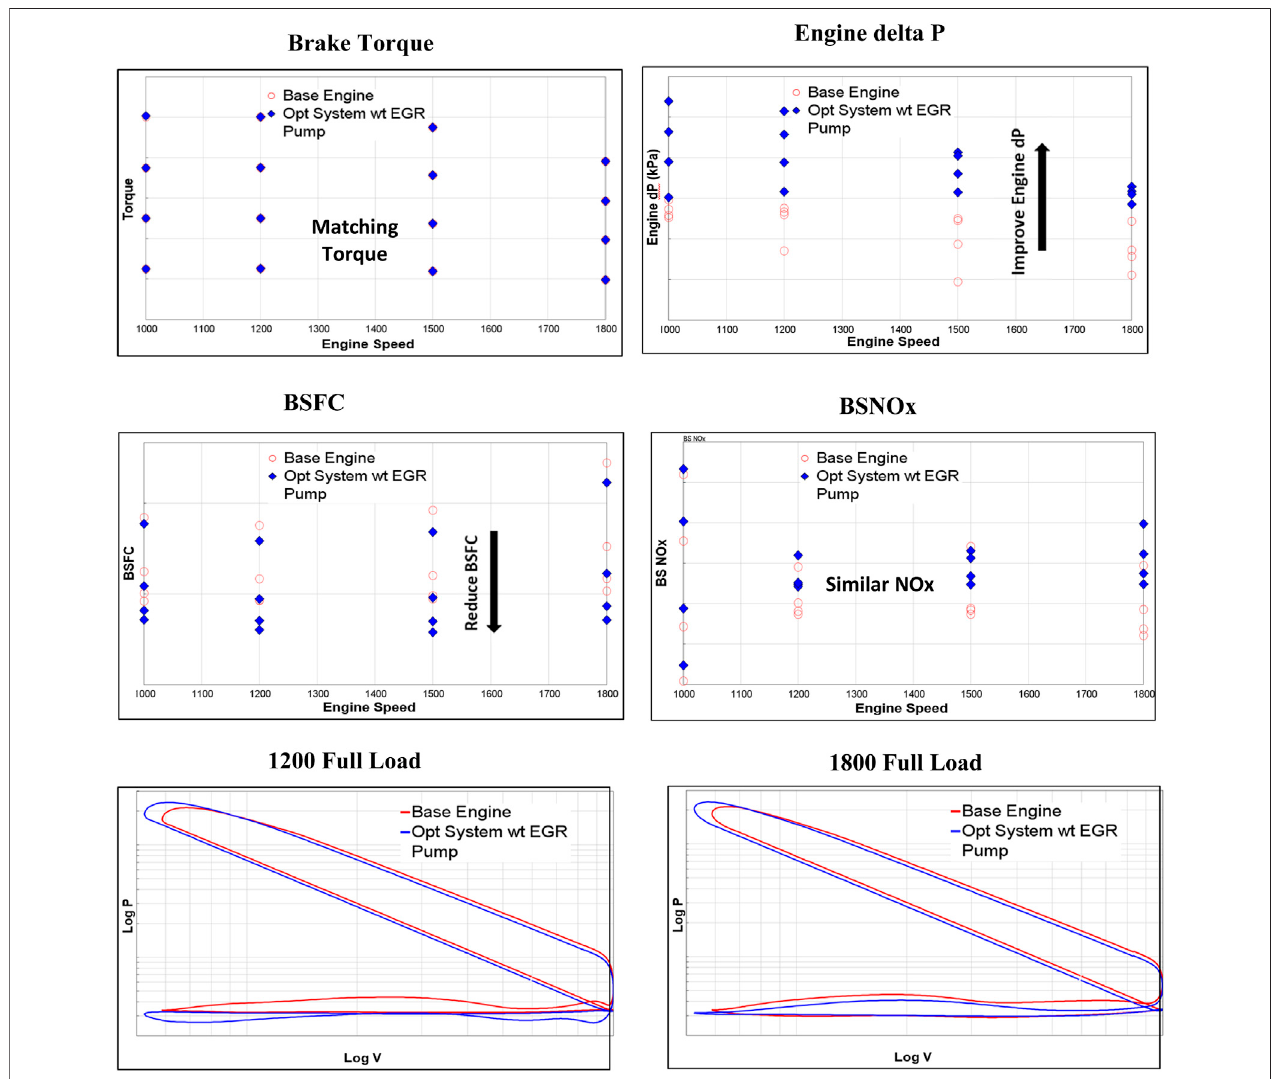
FIGURE 20 | Key performance parameter comparison between base and new engine architecture.